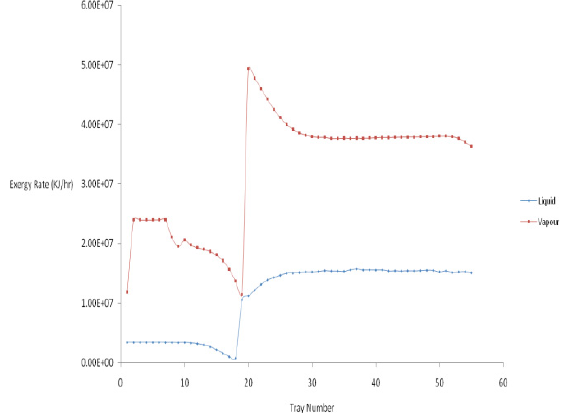
Figure 15. Profile of exergy rate versus tray number for Depropanizer of base case, 30 o C, Reflux Ratio 6